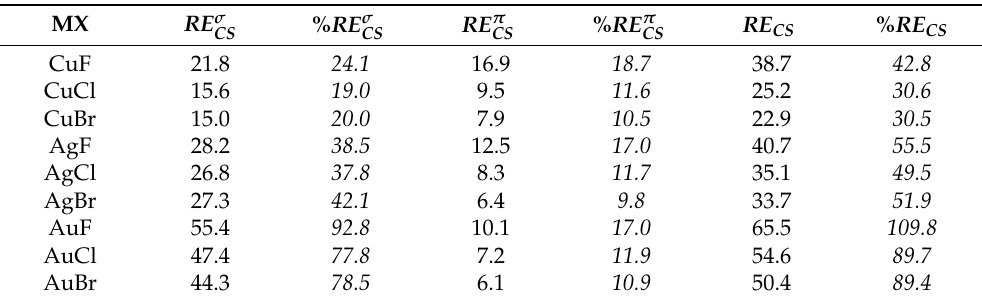
Table 3. Charge-Shift Resonance Energy ( RE CS , in kcal/mol) and its components depicted in Figure 4 obtained at the SD-BOVB/def2-TZVP level. The percentage of charge-shift resonance energy relative to the individual dimer bond dissociation energy is also shown (italic